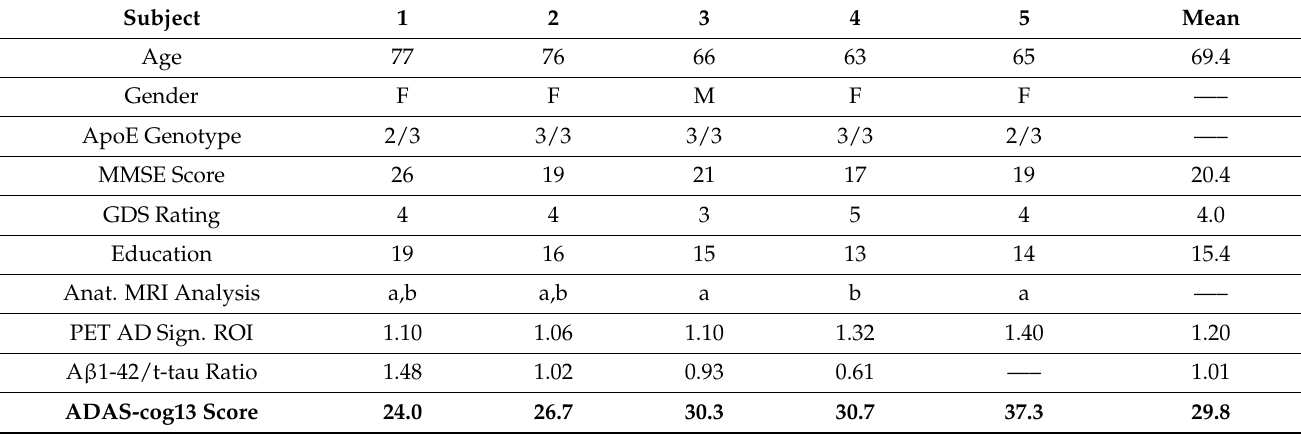
Table 1. Subject